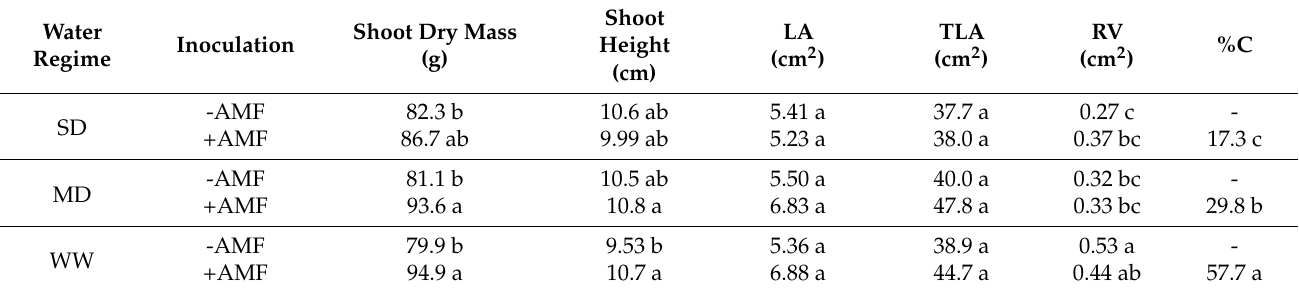
Table 1. Growth and mycorrhizal colonization of H. serratifolius plants subjected to different water regimes in the presence and absence of arbuscular mycorrhizal fungi.